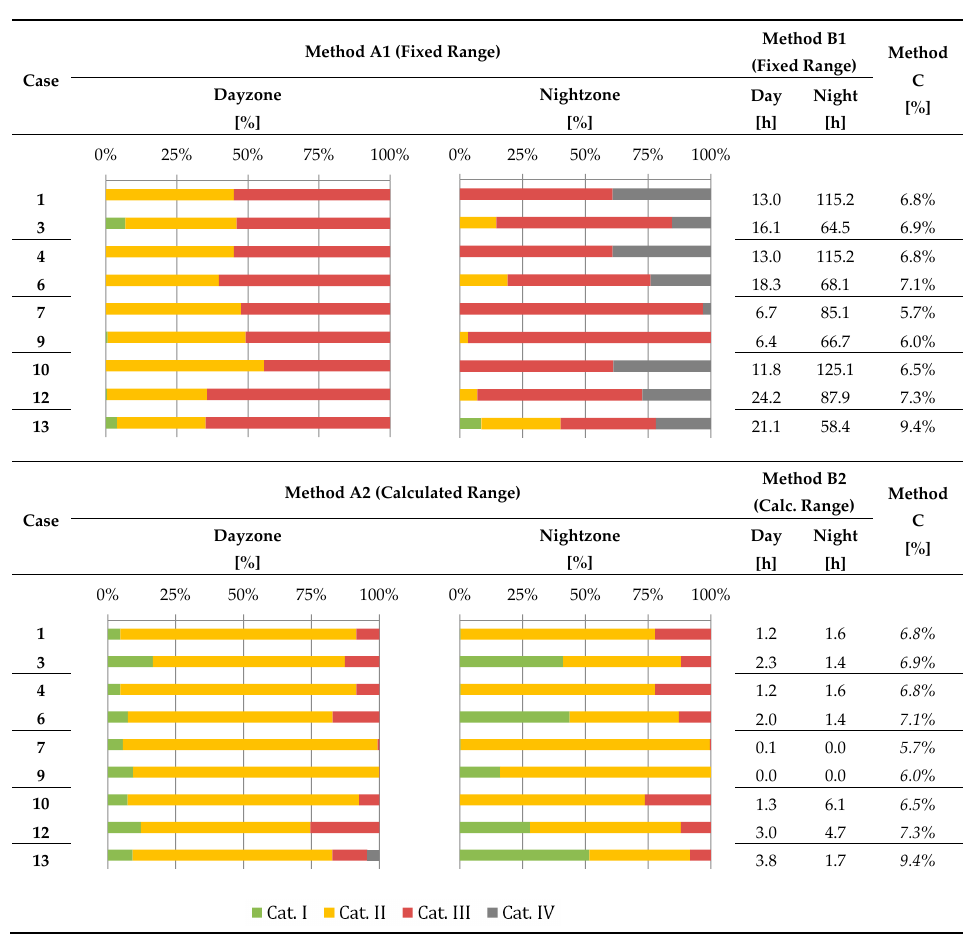
Table 4. Results of the comfort indicators for the different study cases.